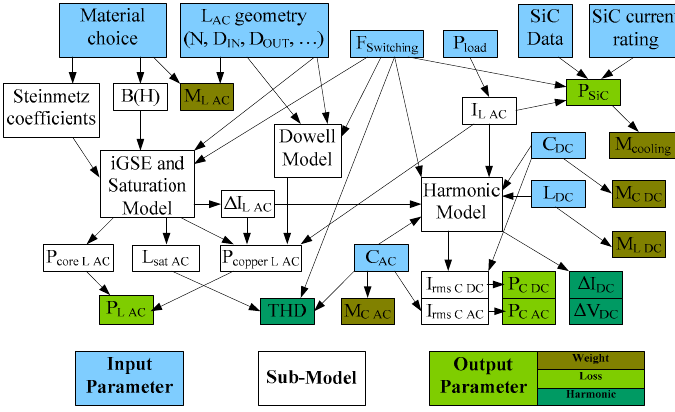
Figure 6. Global synoptic view of the system.